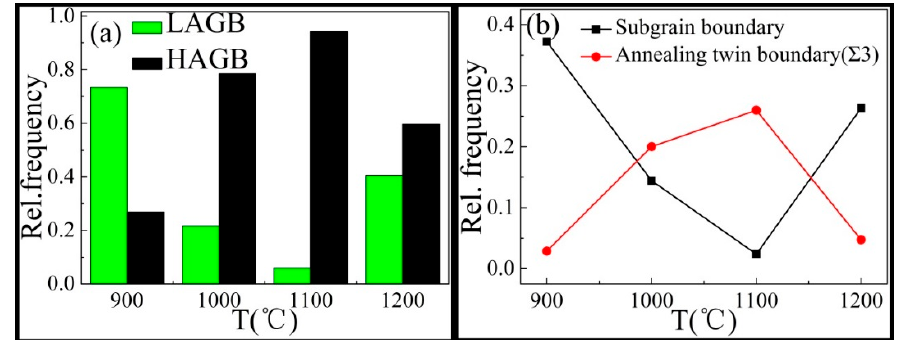
Figure 8. The frequency of the low-angle grain boundary (LAGB), high-angle grain boundary (HAGB), subgrain boundary (SB), and annealing twin boundary ( Σ 3) at different temperatures. ( a ) The LAGB and the HAGB; ( b ) The SB and the Σ 3 .